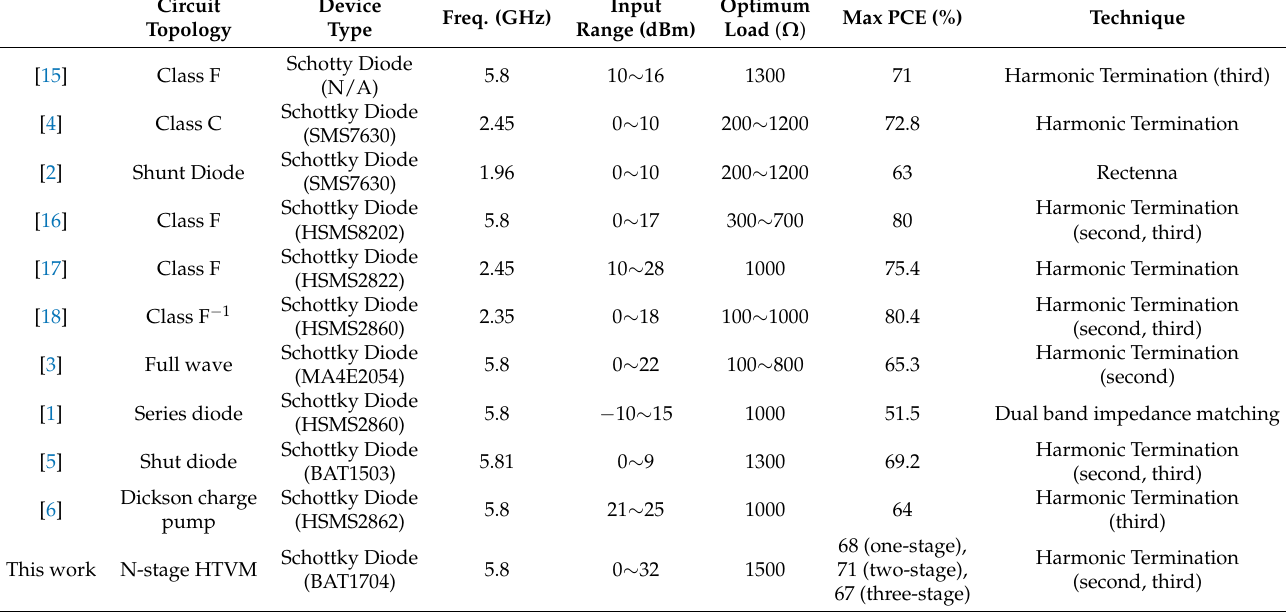
Table 3. Performance comparison between the rectifier proposed in this study and those reported in other previous works. Circuit